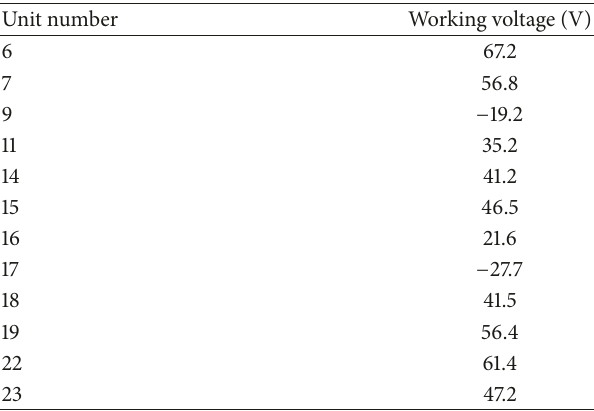
Table 3: Optimal working voltage of piezoelectric